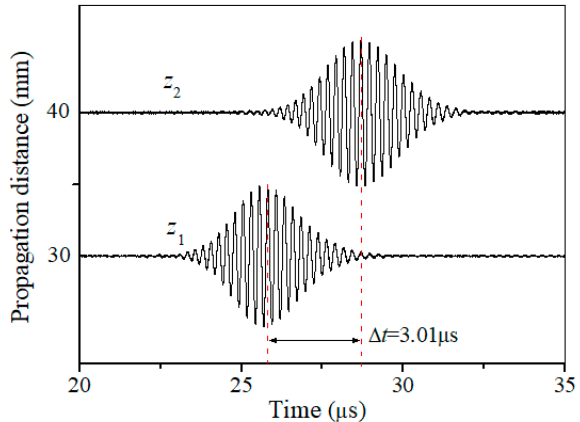
Figure 6. Two time-domain signals detected under different propagation distance z 1 = 30 mm and z 2 = 40 mm.